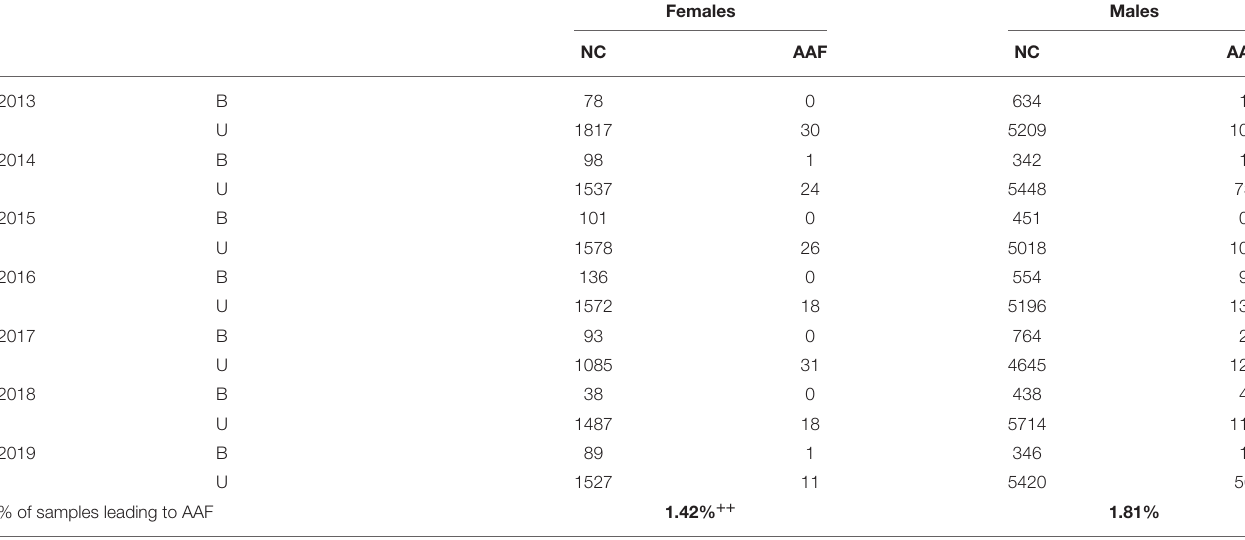
TABLE 1 | Number of controls (NC) for blood (B) and urine (U) and number of controls with AAF in males and females from 2013 to 2019.